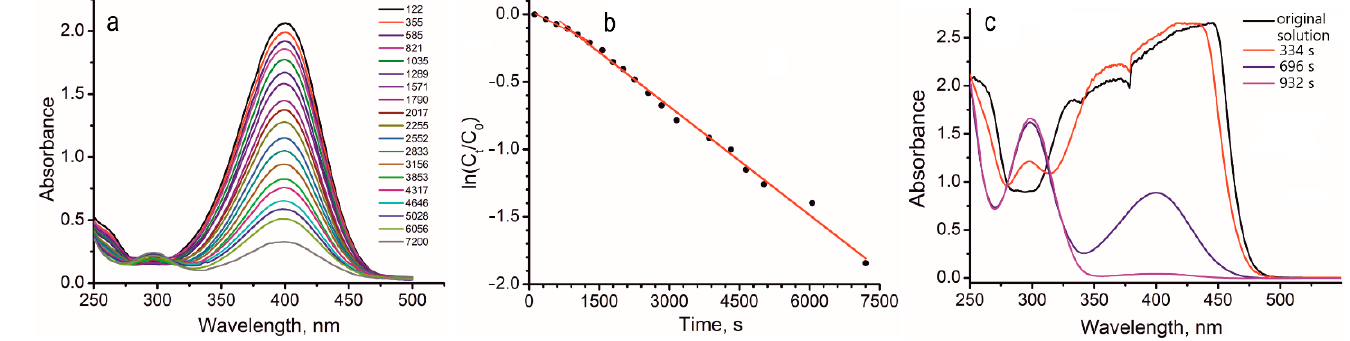
Figure 7. The kinetics measurements: ( a , b ) The experiment with mixture 3 , concentration of p -nitrophenol is 0.1 mM. ( a ) The acquired spectra, ( b ) the function of ln(C t /C 0 ) on time. ( c ) The experiment with mixture 4 ; the spectra for the original solution and the reduction products acquired after 334, 696, and 932 s from the start of the reaction.